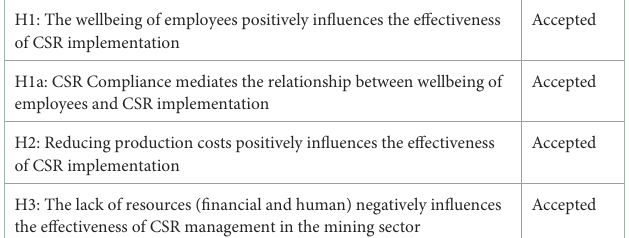
TABLE 5 Hypotheses